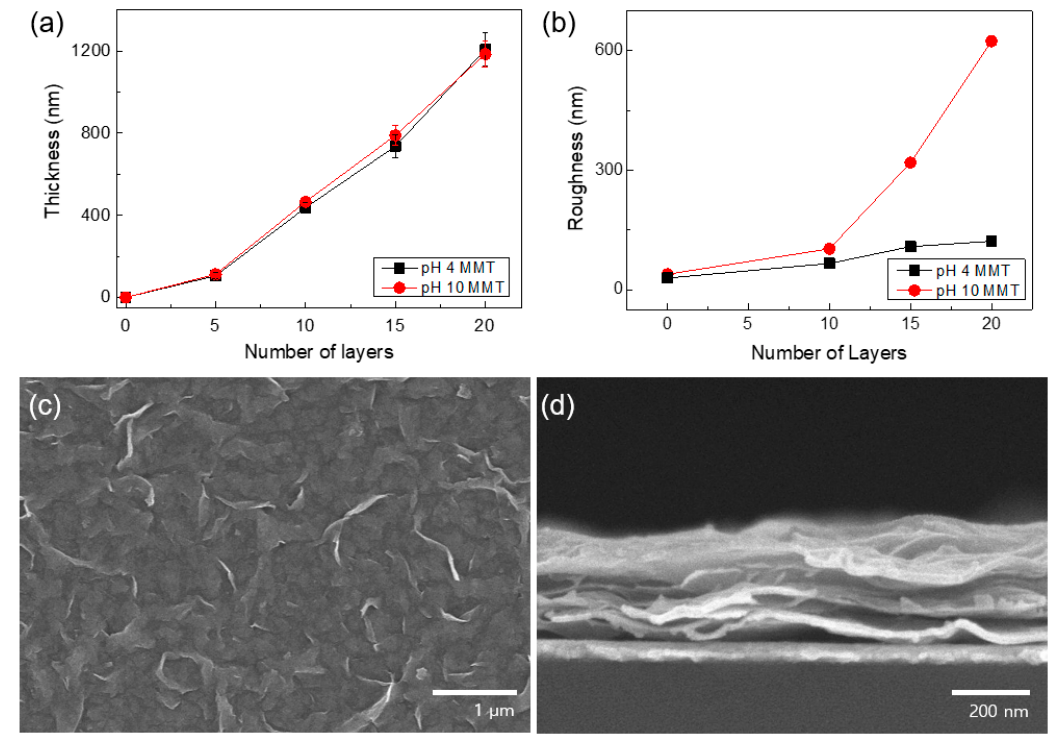
Figure 2. ( a ) Thickness of (MMT-PEI) n deposited with MMT at pH 4 and pH 10, and the pH of PEI was fixed at pH 10. ( b ) Roughness of (MMT-PEI) n deposited with MMT at pH 4 or pH 10. Representative SEM images of ( c ) the surface and ( d ) cross section of (MMT-PEI) n = 10 assembled with MMT at pH 4. (See Figure S1 for the SEM images of the coating deposited with MMT at pH 10.).